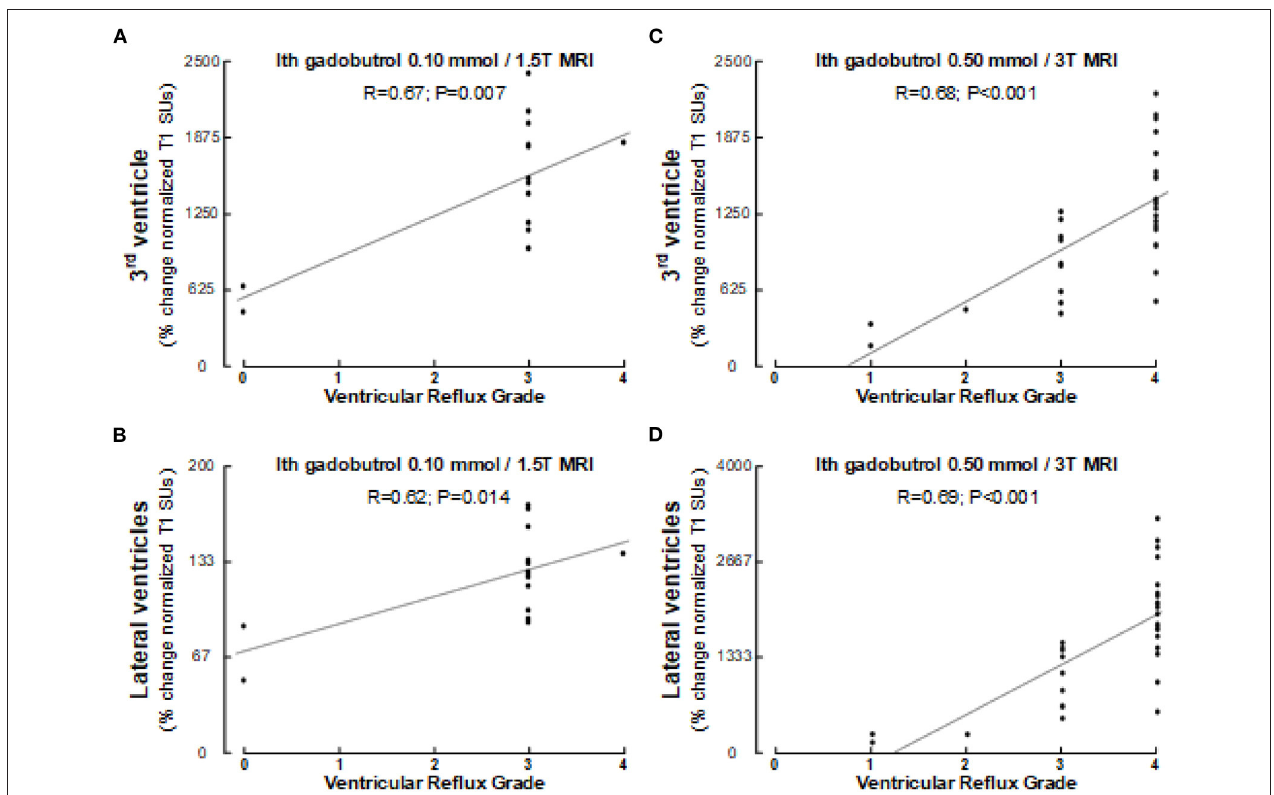
FIGURE 6 | Association between ventricular reflux grade and tracer enrichment 24h after intrathecal gadobutrol.1 mmol (1.5T MRI) within (A) 3rd ventricle and (B) lateral ventricles, and between ventricular reflux grade and tracer enrichment 24h after intrathecal gadobutrol 0.5 mmol (3T MRI) within (C) 3rd ventricle and (D) lateral ventricles. Pearson correlations with significance levels are shown. Of note, Pearson and Spearman’s correlations were